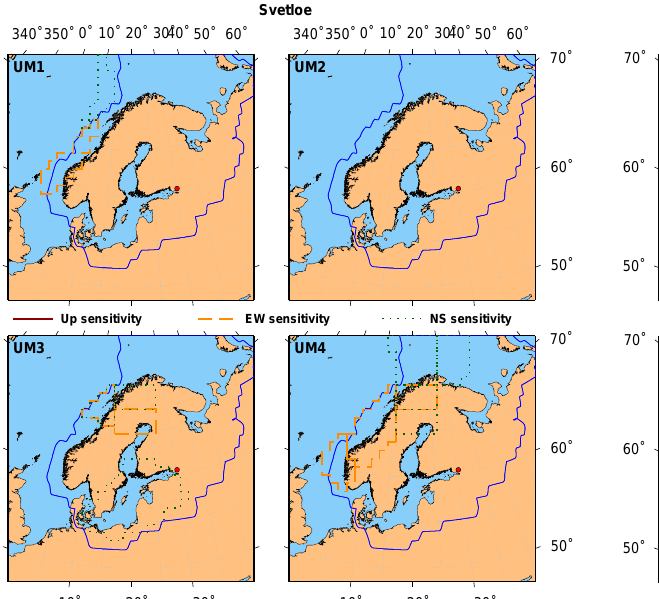
Fig.10. SameasFig.4,butforSmidstrup. Figure 10. Same as Fig. 4, but for Smidstrup.